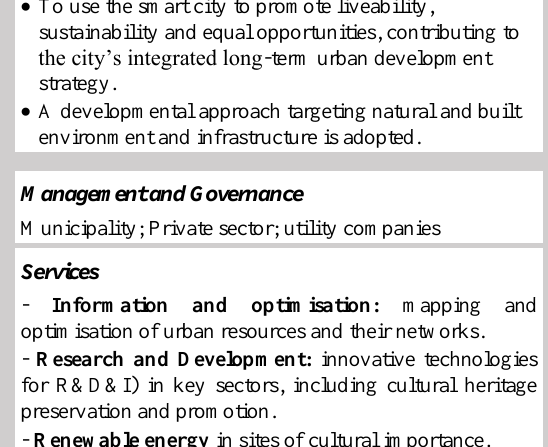
Figure 8. Digital Strategy Canvas for Budapest (authors’